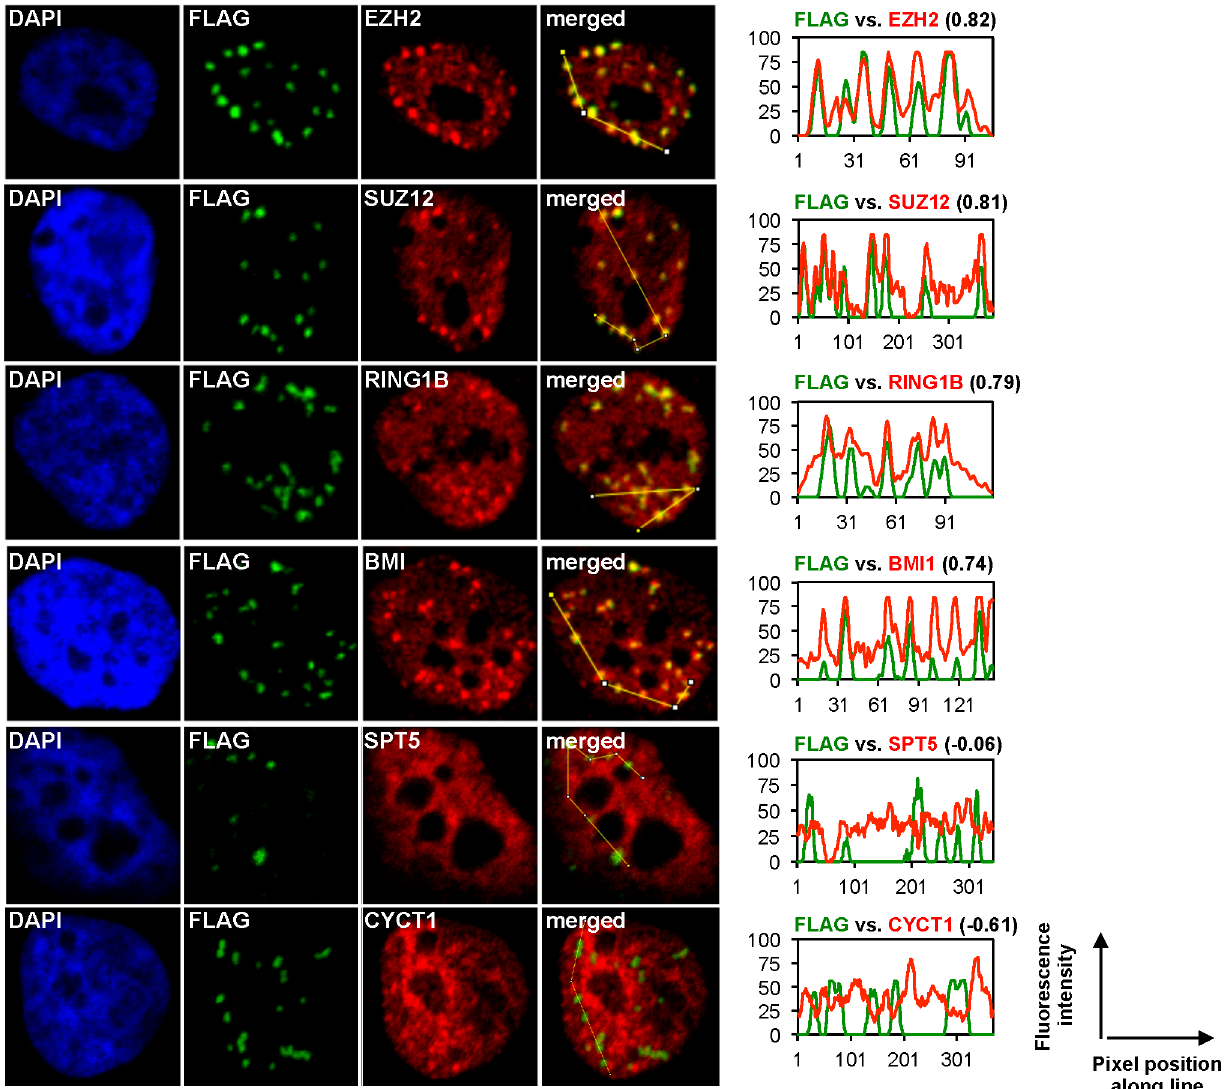
Fig 5. Co-localization and focal enrichment of polycomb proteins with LANA in KSHV-infected cells. KSHV-infected iSLK cells (iSLKBAC16-3xF-LANA) were subjected to confocal microscopic analysis for LANA (Green, false color) and polycomb proteins (Red). SPT5 and CYCT1 served as controls. FLAG antibody was used to detect the 3xF-LANA. Representative LANA puncta were connected by white lines and the co-localization of LANA with the indicated cellular proteins was measured by the image processing program